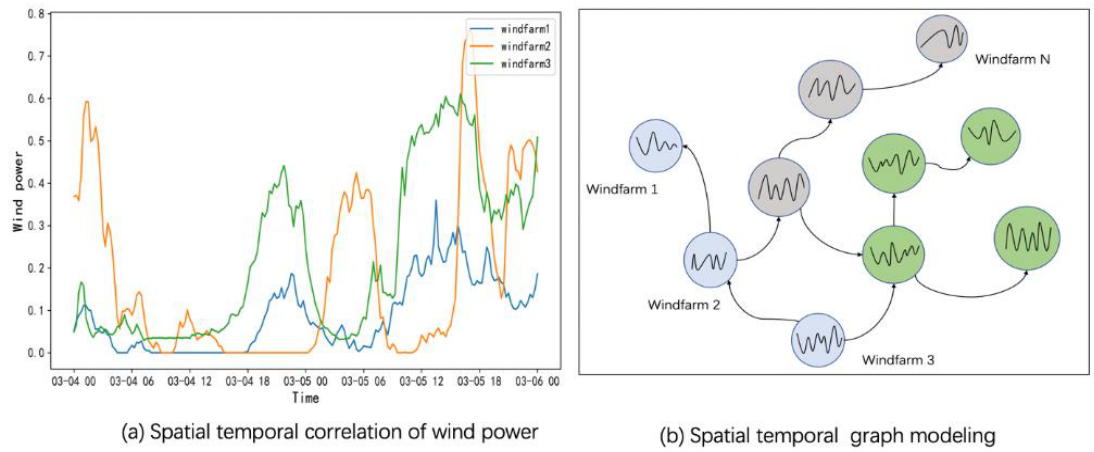
Figure 2. Spatial temporal correlation of wind farms in a region. ( a ) Spatial temporal correlation of wind power; ( b ) spatial–temporal graph modeling.